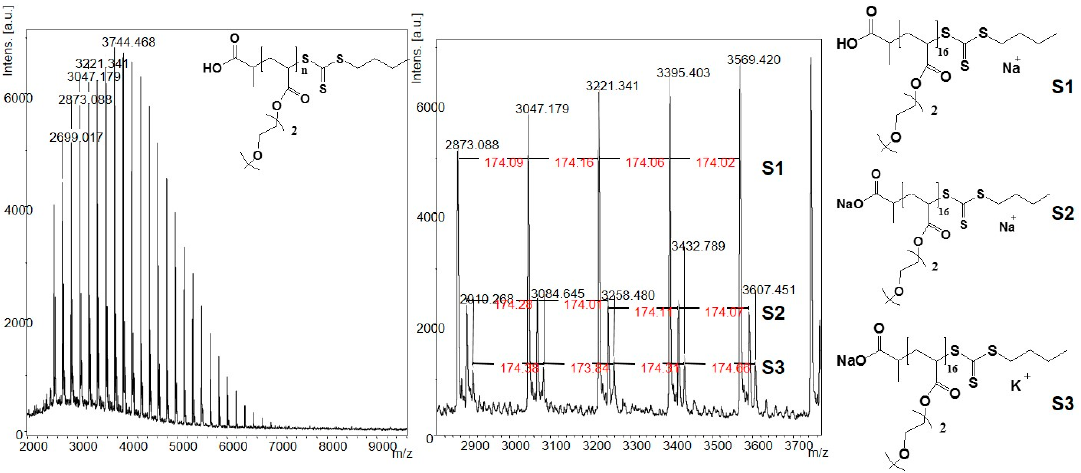
Figure 1. MALDI-TOF spectrum of poly(methoxy di(ethylene glycol)acrylate) ( 3a ). S1, Series 1.